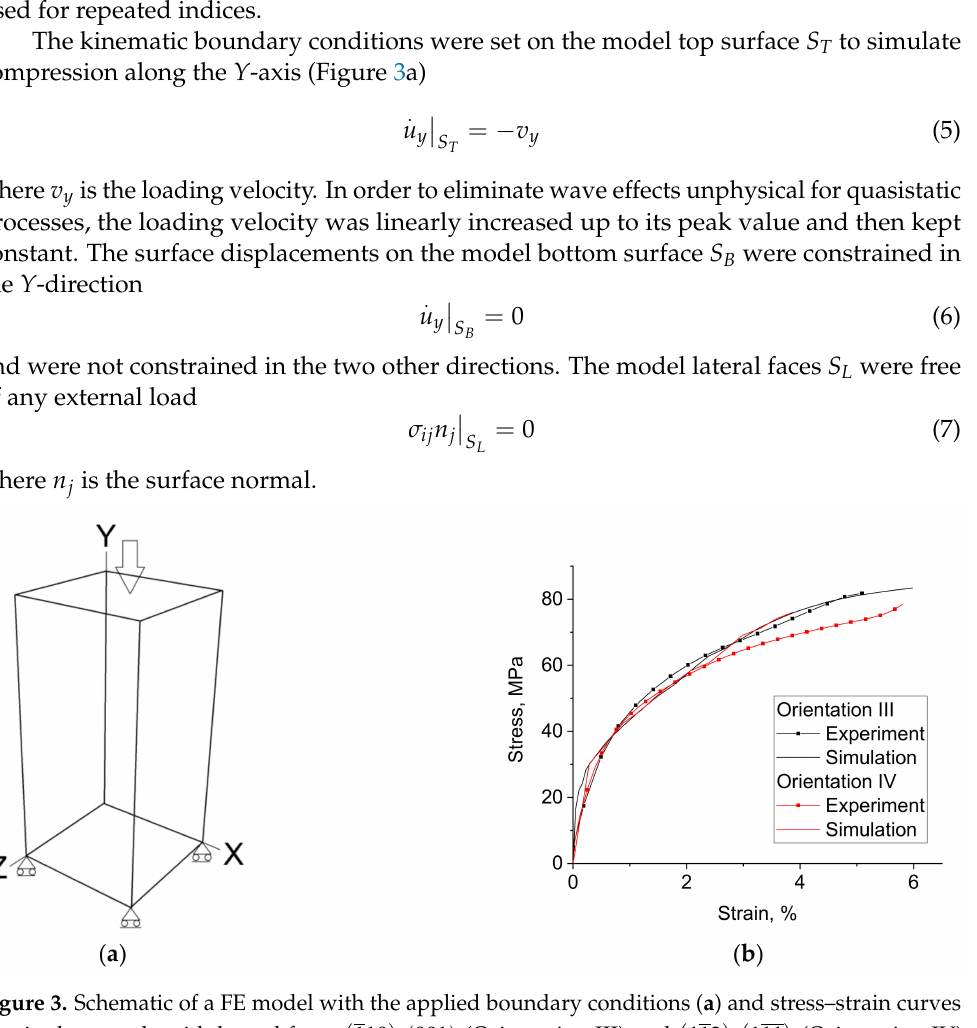
(cid:0) (cid:1) ( 110 001 ) (Orientation III) and